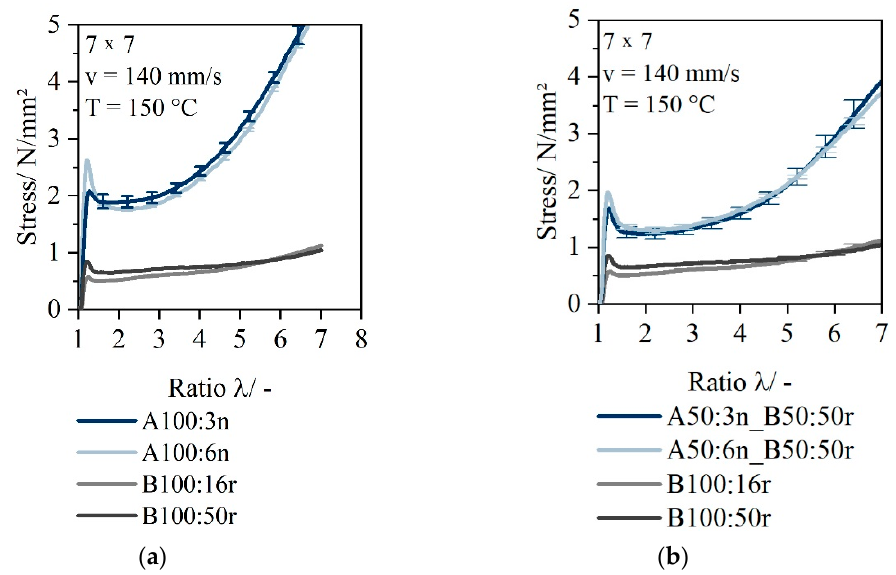
Figure 6. Comparison of stress–draw ratio curve of monolayer sheet 3n (HP525j) and 6n (HP501l) and monolayer sheet 16r (QCP P) and 50r (QCP T) at a temperature of 150 °C ( a ); stress–draw ratio curve of two-layer sheet with Layer A 3n or 6n and Layer B 50r at a temperature of 150 °C ( b ).